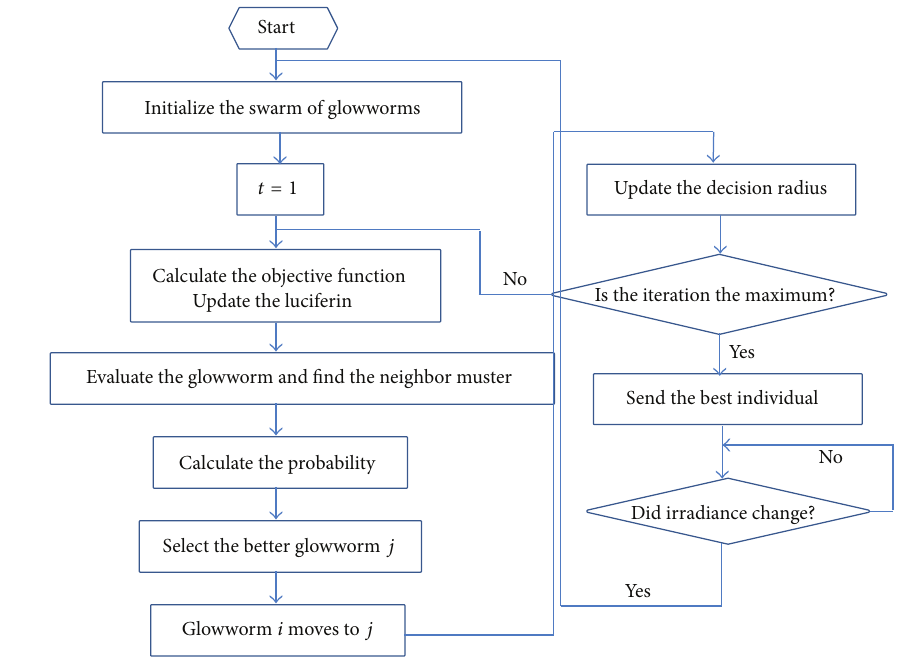
Figure 9: Flowchart of the GSO algorithm.